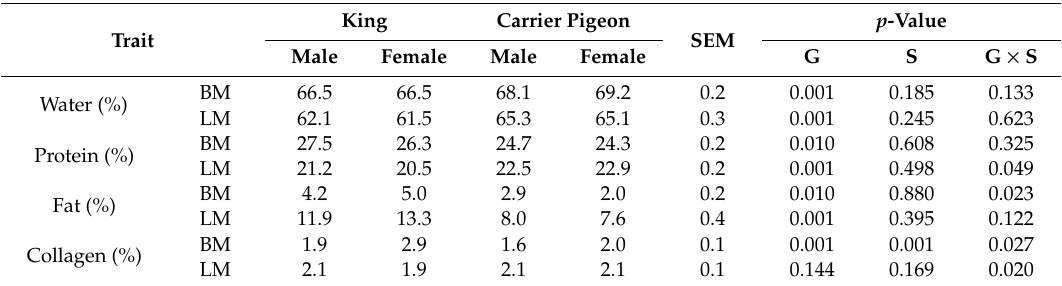
Chemical composition of the breast and leg meat in three-year-old pigeons of di ff erent